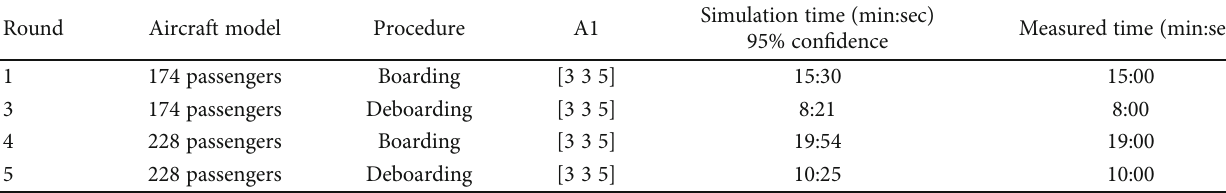
Table 1: Validation procedure